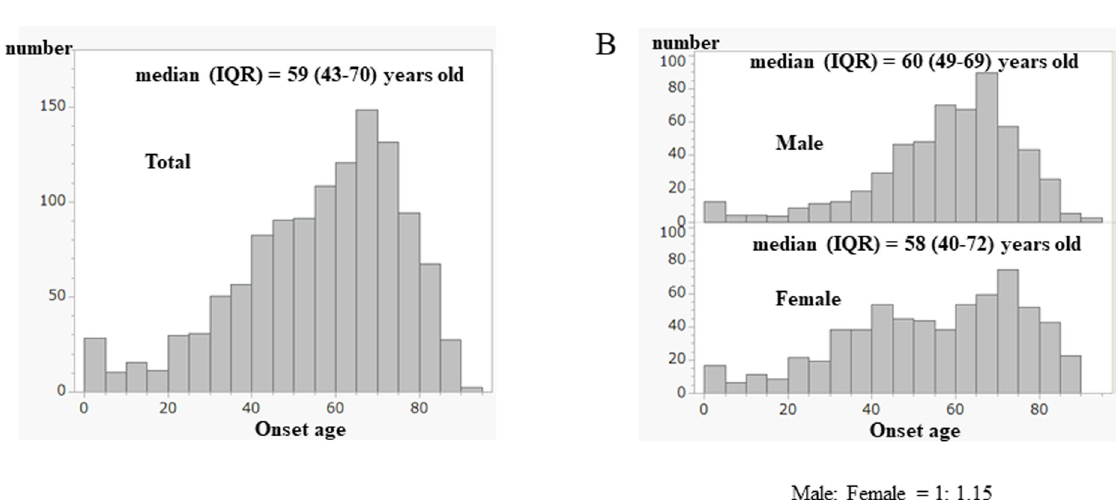
Fig 2. Distribution of onset age of total MG patients. (A) Histogram of onset age of total patients. Median (IQR) = 59 (43–70) years old. (B) Histogram of onset age by sex. Median (IQR): male; 60 (49–69) years old, female; 58 (40–72) years old. The male was significantly older than the female [Wilcoxon-Mann-Whitney test (WMW), p = 0.0299].